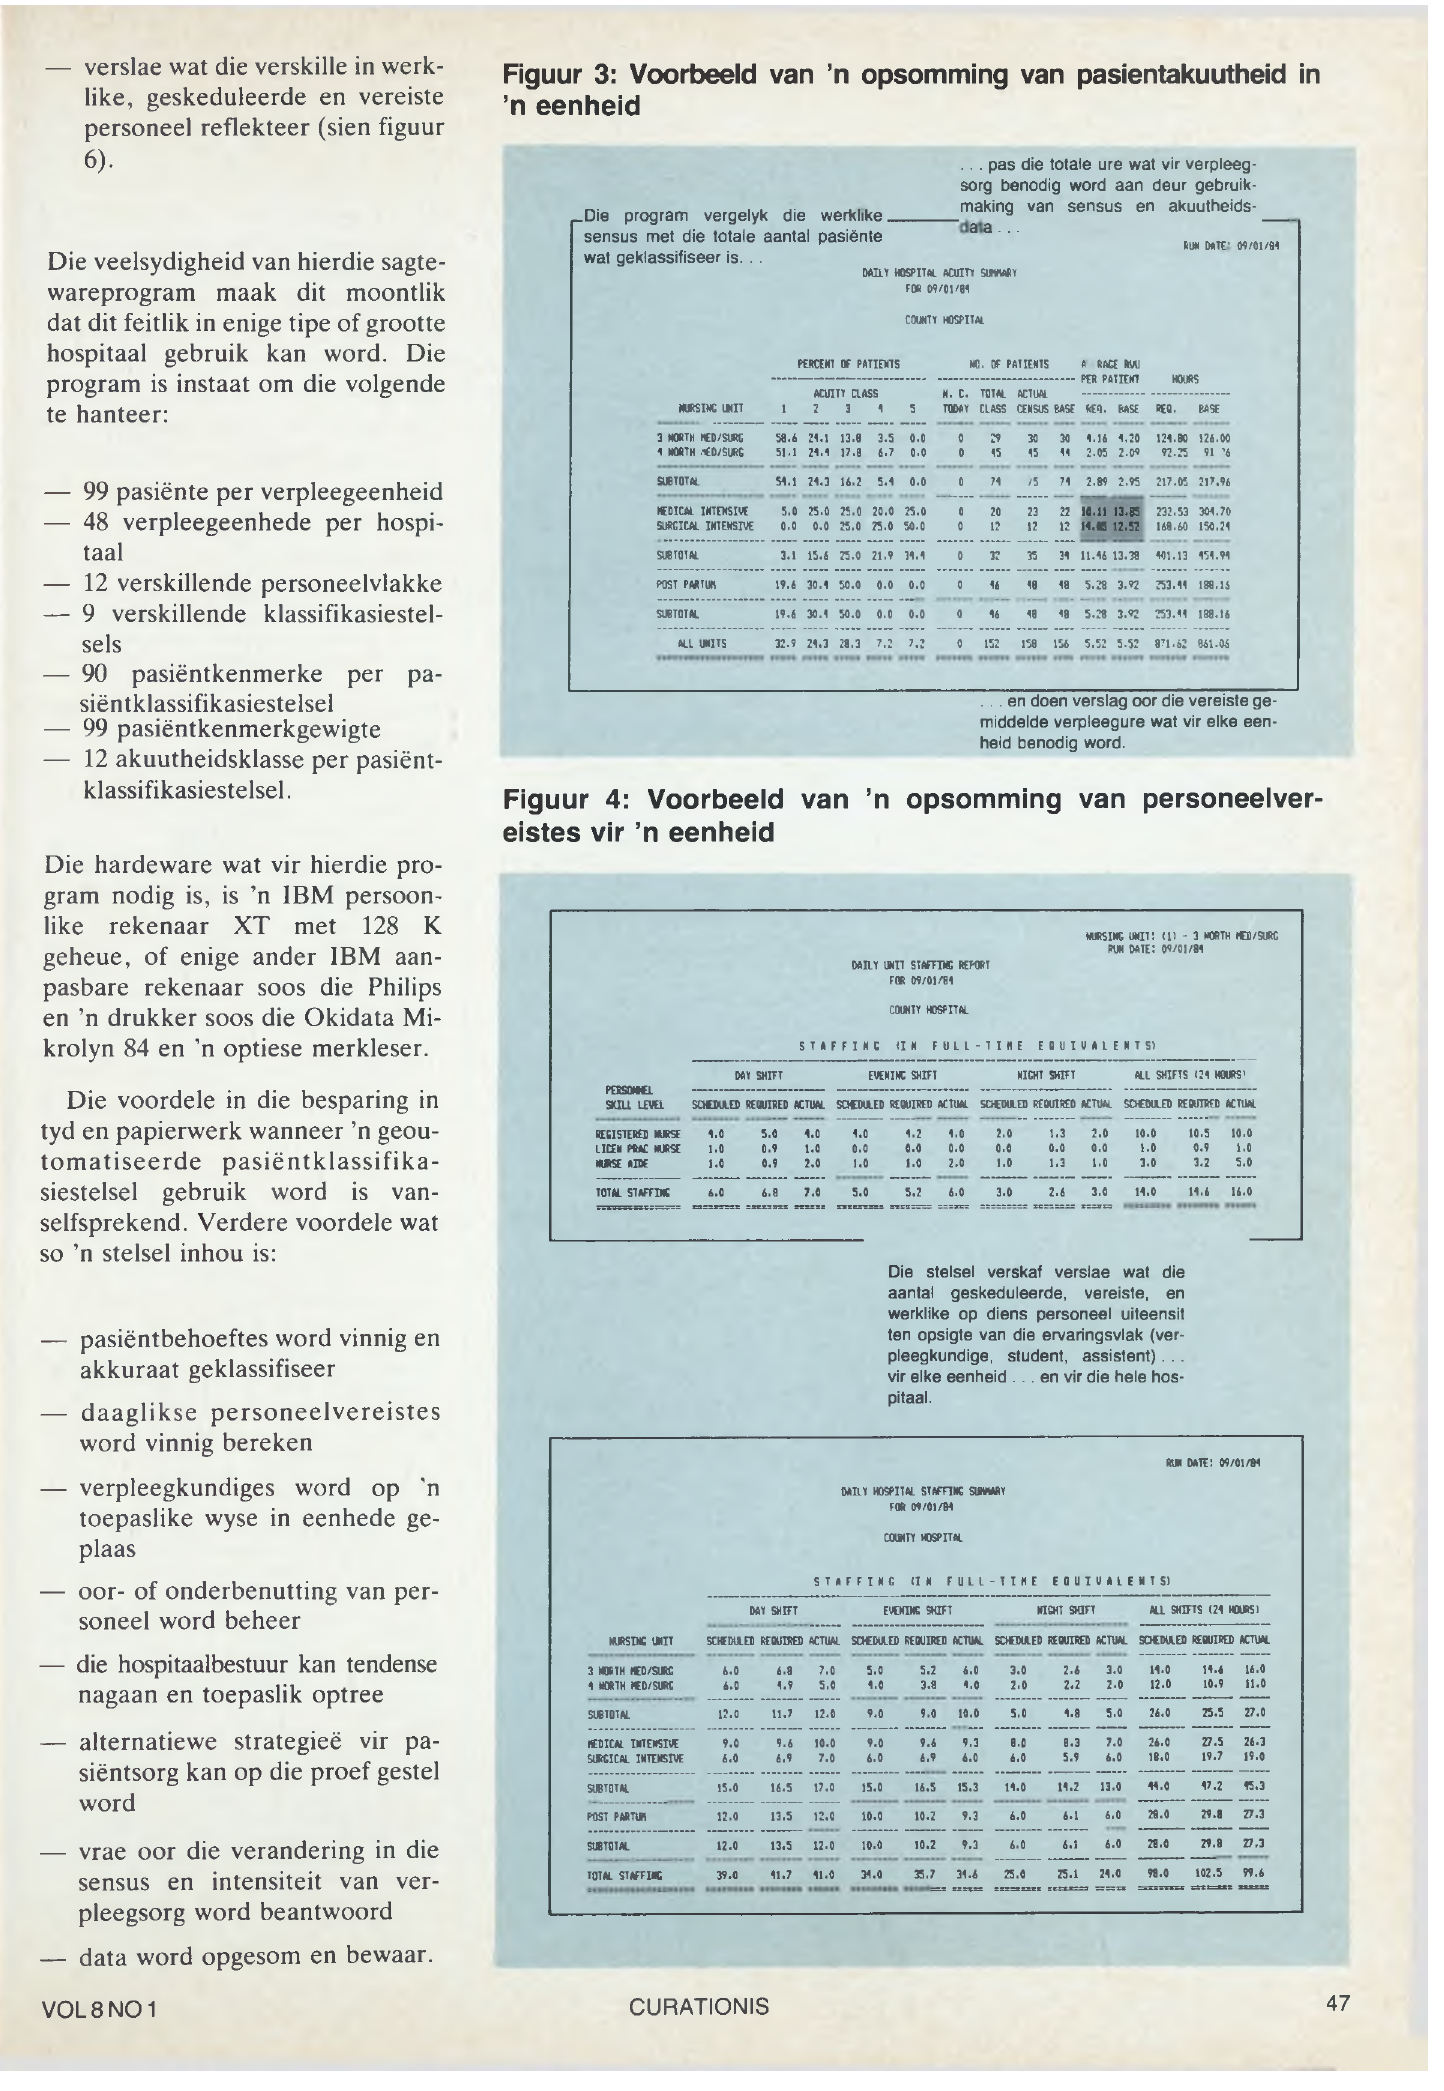
Figuur 3: Voorbeeld van ’n opsomming van pasientakuutheid in ’n eenheid